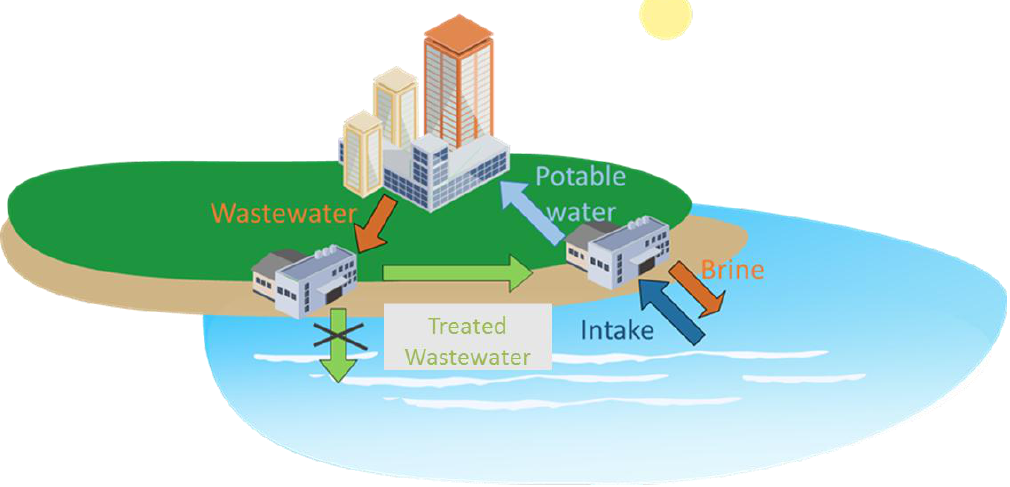
Figure 2. Potential combination of wastewater reuse and seawater desalination to support potable water needs.